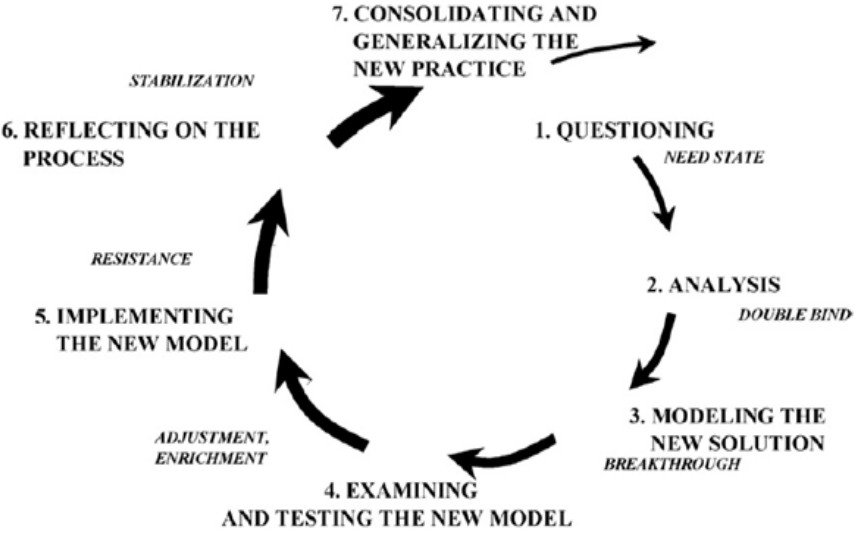
Fig. 2 Sequence of learning actions in an expansive learning cycle (Engeström & Sannino,